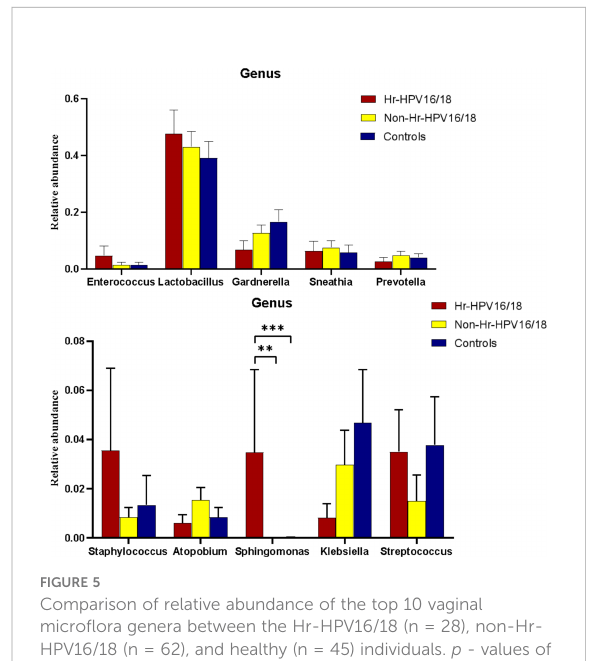
FIGURE 5 Comparison of relative abundance of the top 10 vaginal micro fl ora genera between the Hr-HPV16/18 (n = 28), non-Hr- HPV16/18 (n = 62), and healthy (n = 45) individuals. p - values of 0.05 indicate a statistically signi fi cant difference, **p < 0.01, ***p < 0.001.